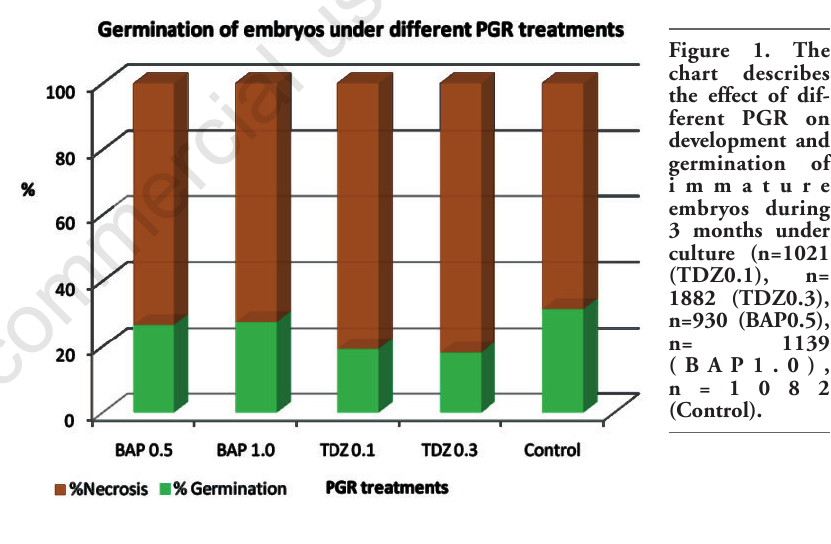
Figure 2. The chart describes the growth in diameter/length of green embryos/ PLBs under dif- ferent PGR treat- ments [n=77 (TDZ0.1), n=78 (TDZ0.3), n=103 (BAP0.5), n=162 (BAP1.0), n=126 (Control)].